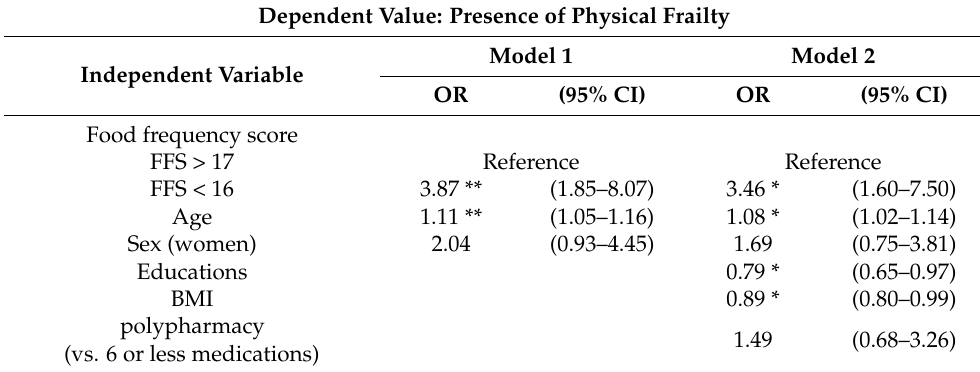
Table 4. Association between loss of Food frequency score and physical